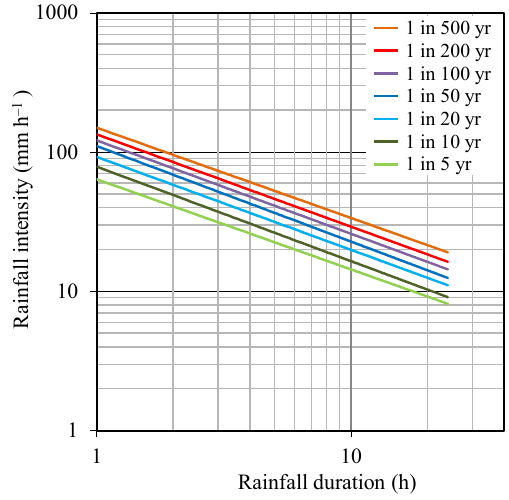
Figure 3. Rainfall intensity–duration–frequency curves for Saint Lucia developed by Klohn-Crippen (1995) using Gumbel analysis of 40 years of hourly rainfall data from 15 rainfall